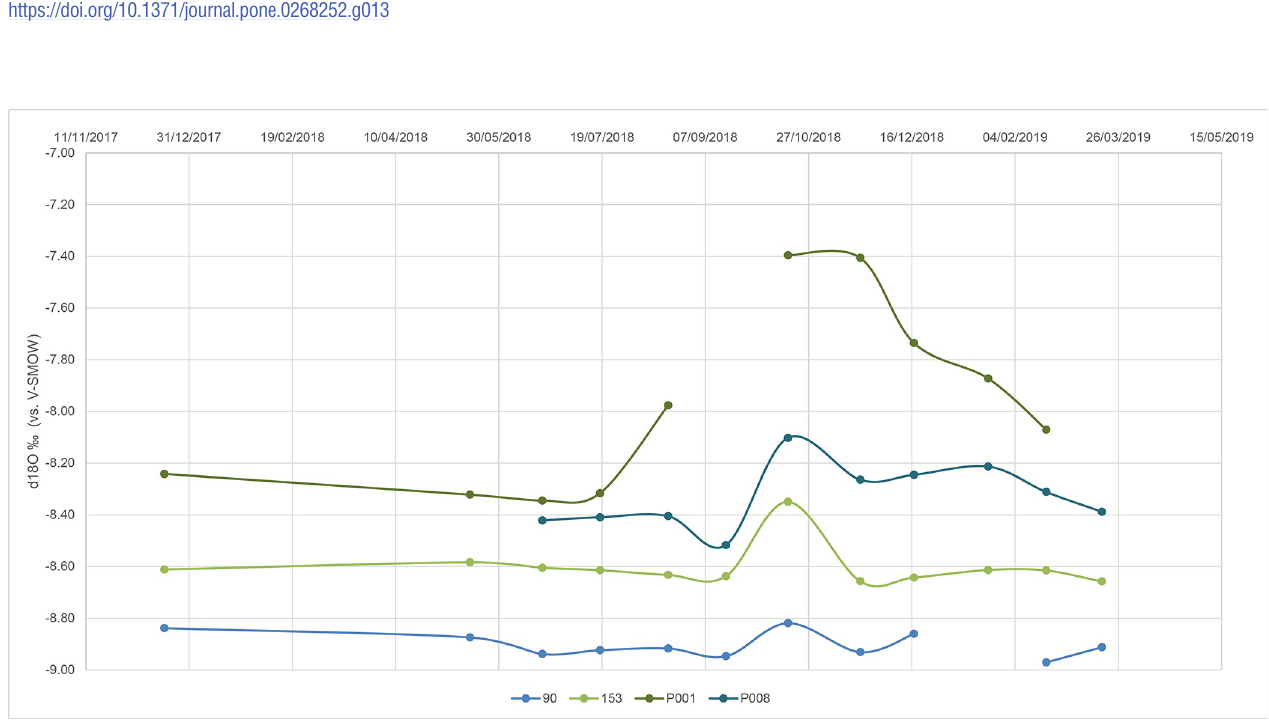
Fig 14. Variation in the isotopic signature of spring waters over time.